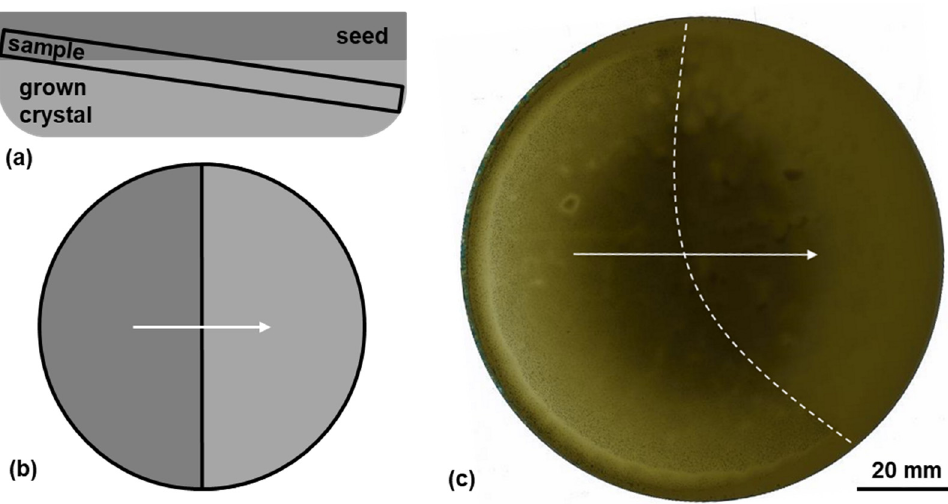
Figure 1. ( a ) Schematic of the sample’s position cut from the respective crystal; ( b ) schematic resulting sample; the arrow indicates the position of the line scan of the Raman measurements; ( c ) optical scan of the wafer cut from crystal A with the (0001)-side up; the arrow indicates the position of the line scan of the Raman measurements, the dashed line marks the transition between the seed (left side) and the grown crystal (right side).